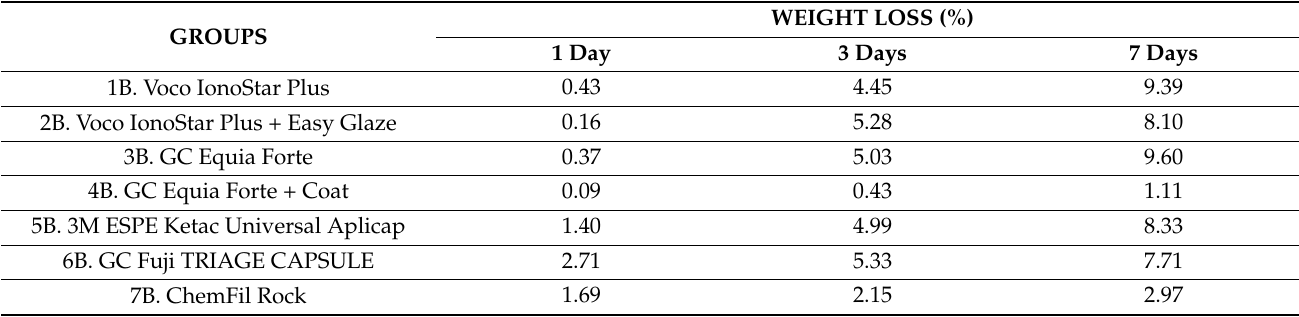
Table 4. Weight loss of glass-ionomer cements after 1, 3, and 7 day of acid challenge: data are expressed as medium percentage of weight loss.